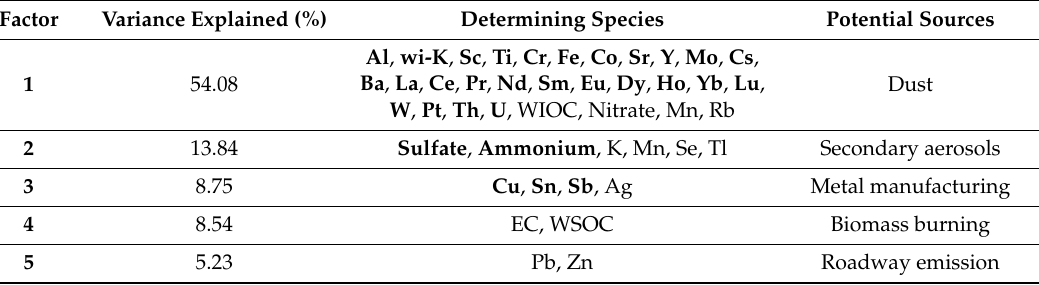
Table 1. Results of Principle Component Analysis